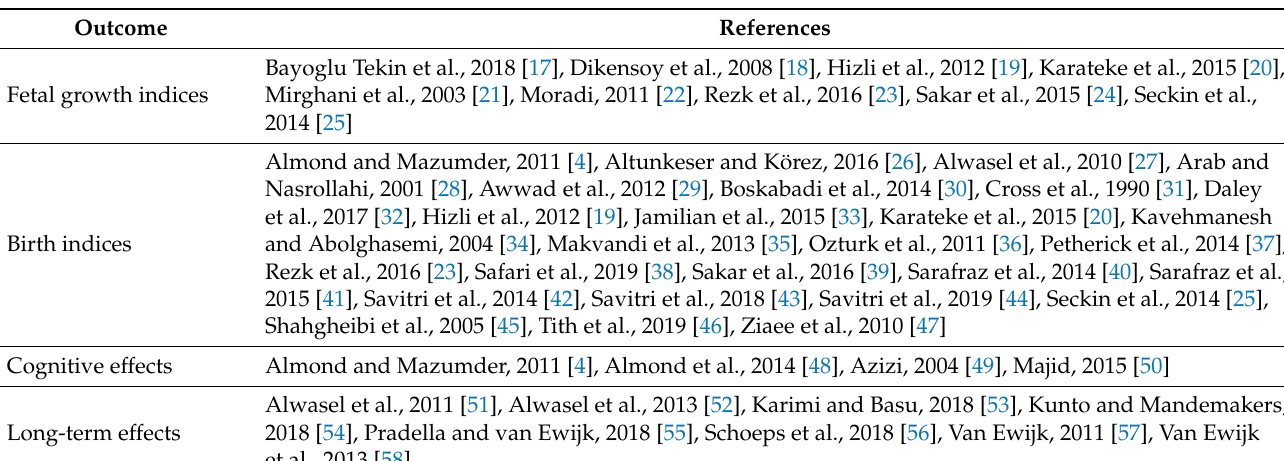
Table 1. Studies categorized based on their specific investigation.